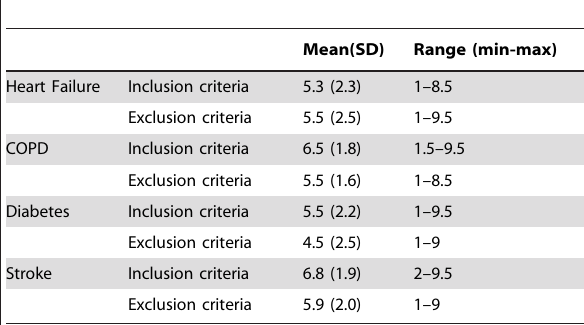
Table 1. Replicability of Inclusion and Exclusion criteria, by